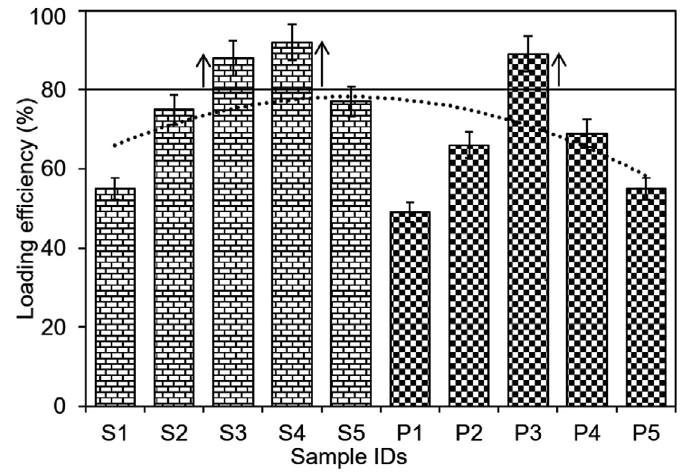
Fig. 3 Percent loading efficiency of newly in-house engineered silver and platinum nanoparticles into/onto graphene- based